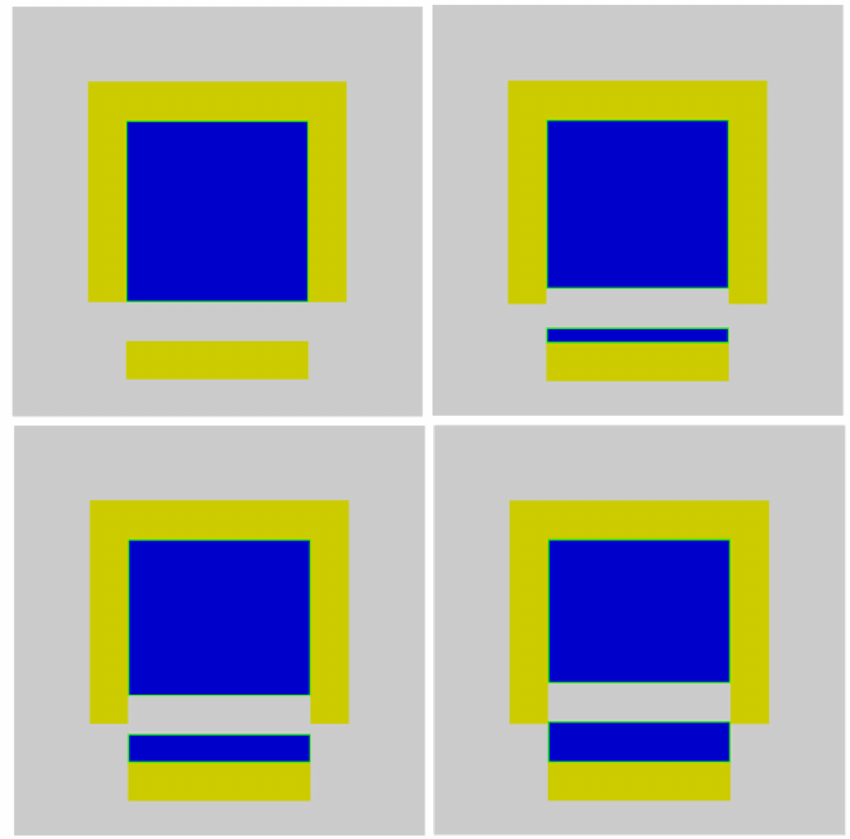
Figure 6. Different cases for the investigation of the shutdown efficiency between only moving the reflector (left top) and moving the reflector with increasingly sized layers (10 cm top right, 20 cm bottom left, and 30 cm bottom right) of the core contained in a separated